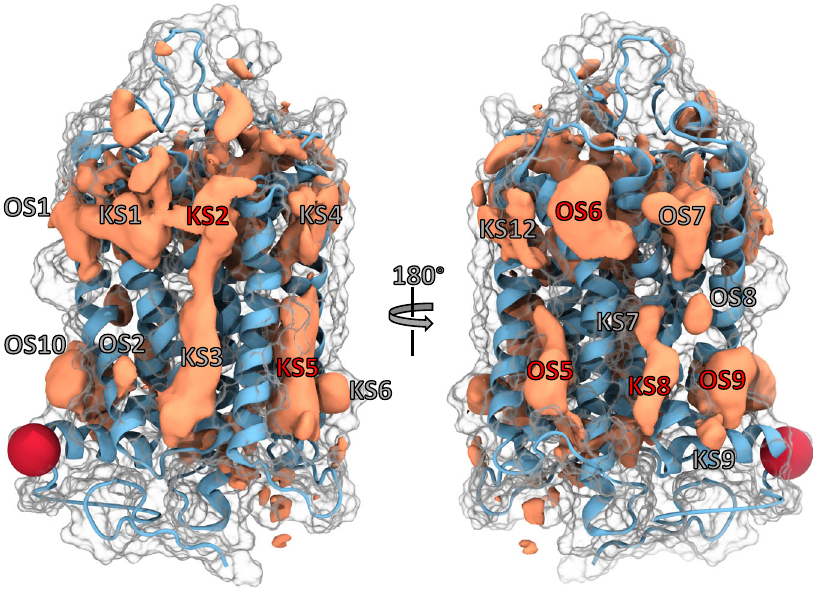
Fig. 1 Representative depiction of the GPCR pocketome. Cumulative densities for all class A GPCRs (orange volumes) are shown projected on the structure with PDB 1F88 ([https://doi.org/10.2210/pdb1F88/pdb]; ice blue ribbon). The surface is indicated white transparent. Visible hotspots (pockets) located at the lipid-facing receptor portion around the 7TM bundle are labelled either as OS (Orphan Site) or KS (Known Site). A more detailed description of their location is provided in the text and Table 1. We note that OS3 was described in the most recent X-ray structure PDB 7M3J 64 [https://doi.org/10. 2210/pdb7M3J/pdb] during writing of this manuscript. We therefore re-labelled this site to KS12. Furthermore, OS4 was not found in the class A densities. Three known and three orphan pockets (red labels) are discussed in more detail in the text. The red sphere indicates the tip of HVIII and has been included for ease of orientation. Source data are provided as a source_data.xlsx fi le. Table 1 List of all pockets observed after probe docking, their approximate locations, and classes for which the densities are